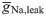
Sensitivity analysis.Sensitivity of (A) the somatic membrane potential (ϕsm) and (B-E) ion concentrations outside the soma to variations of the leak conductances g¯Na,leak, g¯K,leak, and g¯Cl,leak, the ATPase pump strength ρ, and the co-transporter strengths Unkcc1 and Ukcc2. The model was run for 10 s with default parameters. At t = 10 s, selected parameters were changed, one per simulation, by ±15% of their default value. In all cases, the model approached a new steady state during the 3 min simulation, which was not dramatically different from the default steady state. The resting potential was most sensitive to g¯Na,leak. This was not surprising, as Na+ has the reversal potential (57 mV) that is furthest away from the resting potential (≈ -68 mV), making the driving force (ϕm−Ek) largest for Na+. All concentration variables were most sensitive either to g¯Na,leak or ρ. For [Ca2+]se and [Cl−]se the sensitivity to these parameters were indirect, i.e., through their effects on the resting potential and driving forces. (A-E) Results only shown for somatic compartments, as they were almost identical in the the dendritic compartments. Only extracellular concentrations were shown, but intracellular concentrations followed the same time coarse and intracellular deviances from default values were smaller (due to larger intracellular volume fraction). As we showed in Fig 3L, the Ca2+/2Na+ exchanger is not active during rest, and it was therefore not included in the sensitivity analysis.